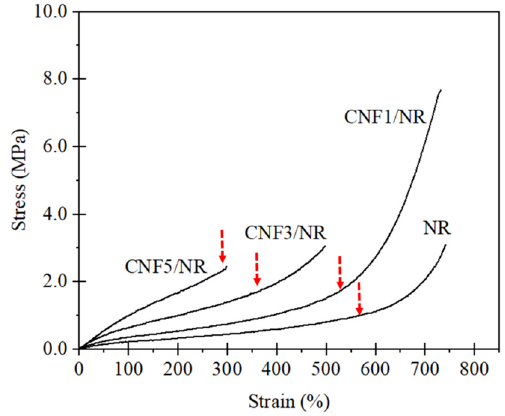
Figure 4. Stress–strain curves of the NR and the CNF/NR nanocomposites.